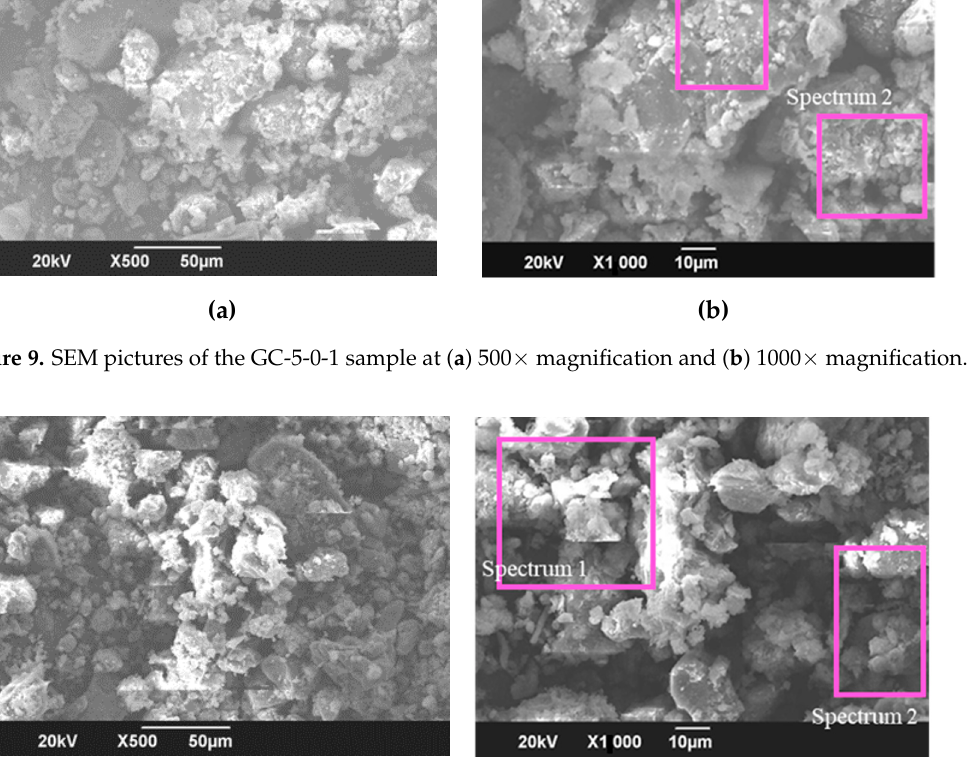
Figure 10. SEM pictures of the GC-5-0.8-1 sample at ( a ) 500× magnification and ( b ) 1000× magnifi- 280 cation.